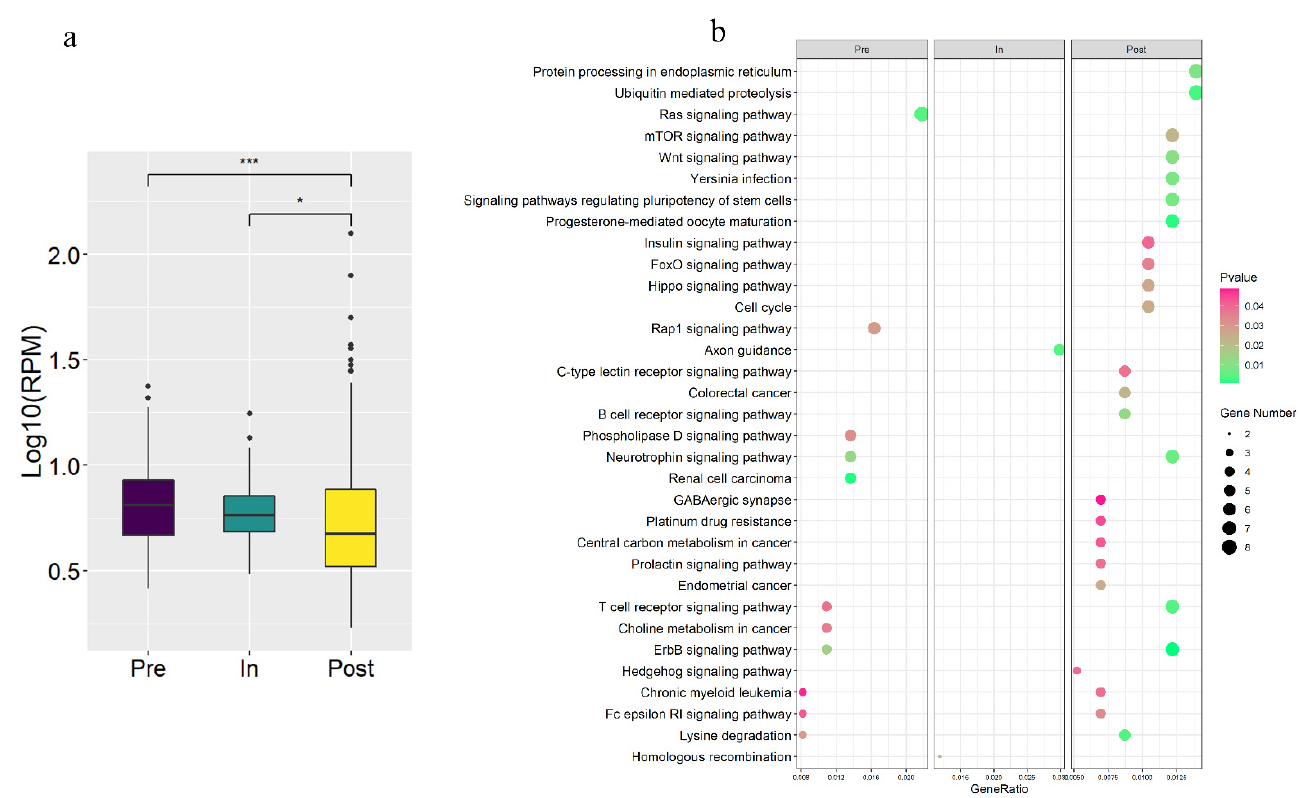
Figure 3. Analysis results of stage-specific circRNAs. ( a ) Expression level of stage-specific circRNAs during Pre-, In-, Post-puberty. ( b ) KEGG analysis with parental genes of stage-specific circRNAs during pre-, in-, post-puberty ( p < 0.05). * p < 0.05, *** p < 0.001.